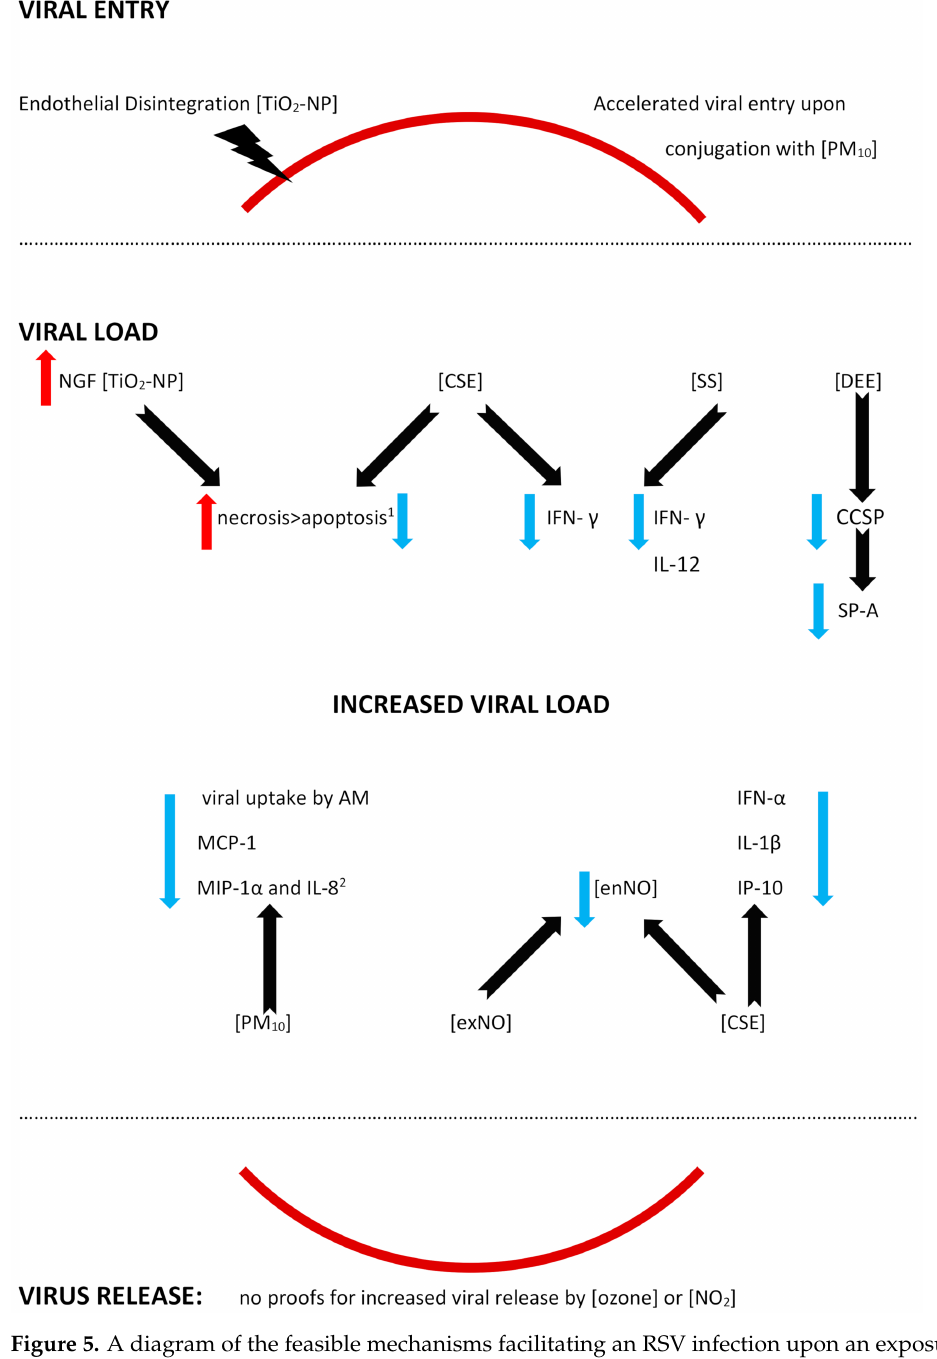
Figure 5. A diagram of the feasible mechanisms facilitating an RSV infection upon an exposure to the different air pollutants. The activity of the air pollutants is shown with the black solid arrow, while the directions of the effects are marked with red (increase) or blue (decrease) arrows; the red solid line symbolizes a division between the extracellular and intracellular space (in the case of a viral entry and a viral release), and the red solid lines are separated from the rest of the figure by black dotted lines, since the remaining effects (shown in the central part of the scheme) are reported in extra- or intracellular spaces. Please note: the figure has only a demonstrative character and is based on the literature found for the purposes of this review. The effects of the air pollutants might vary with regards to the presence/absence of the mechanism, its extent, and its effects. The mechanisms might be influenced by other, not verified or not shown, pathways. The mechanisms might be dose-dependent, time-dependent, exposition sequence-dependent, and